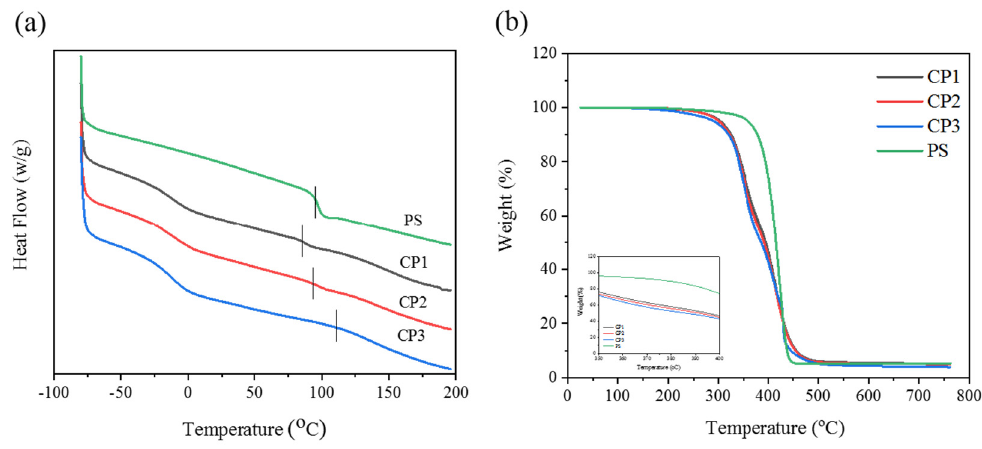
Figure 4. Thermal properties of copolymers: ( a ) DSC thermograms; ( b ) TGA curves.